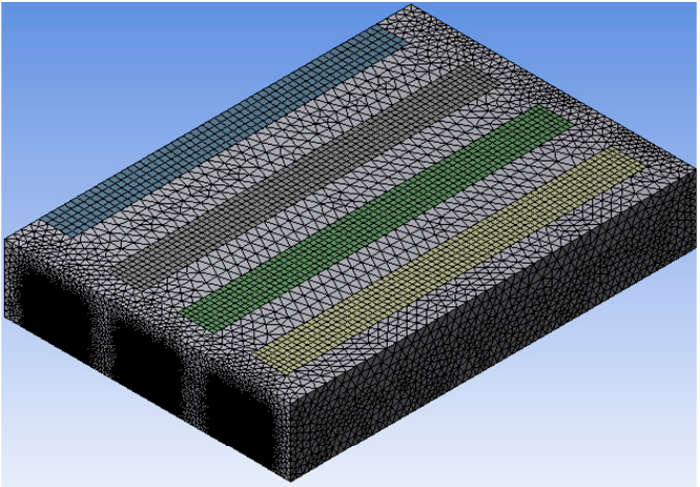
Figure 1. The representation of three-dimensional geometry developed for the present study.